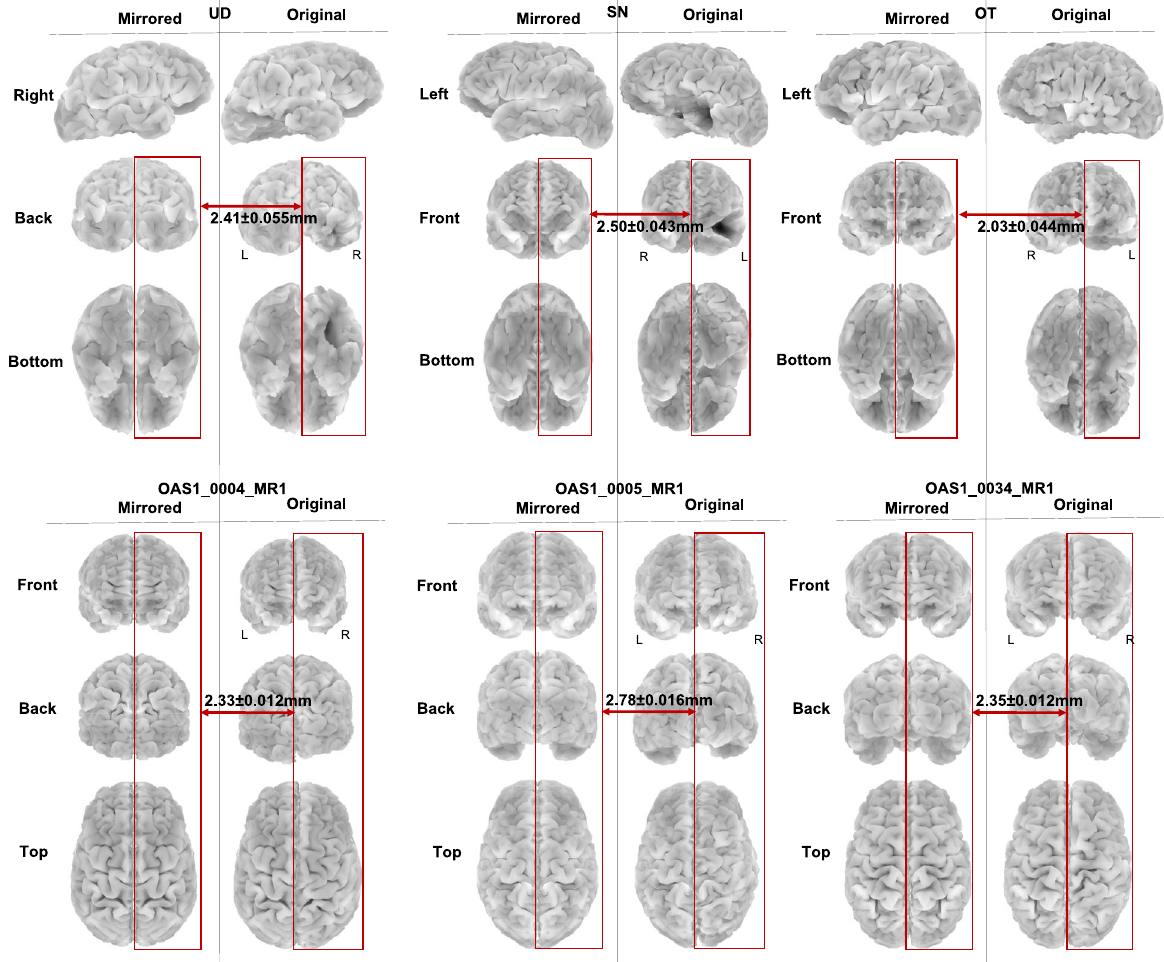
Fig. 5 Average distance of the symmetric brain model from the original brain model. The average brain distance is shown in patients with lobectomy, i.e., UD with right occipitotemporal lobectomy, SN with left temporal lobectomy, and OT with left frontotemporal lobectomy, as well as in three healthy controls, namely, OAS1_0004_MR1, OAS1_0005_MR1, and OAS1_0034_MR1. The average distance for all patients and healthy controls are <3 mm, which makes the symmetric brain model a reasonable choice for the silence localization task, as it does not introduce substantial